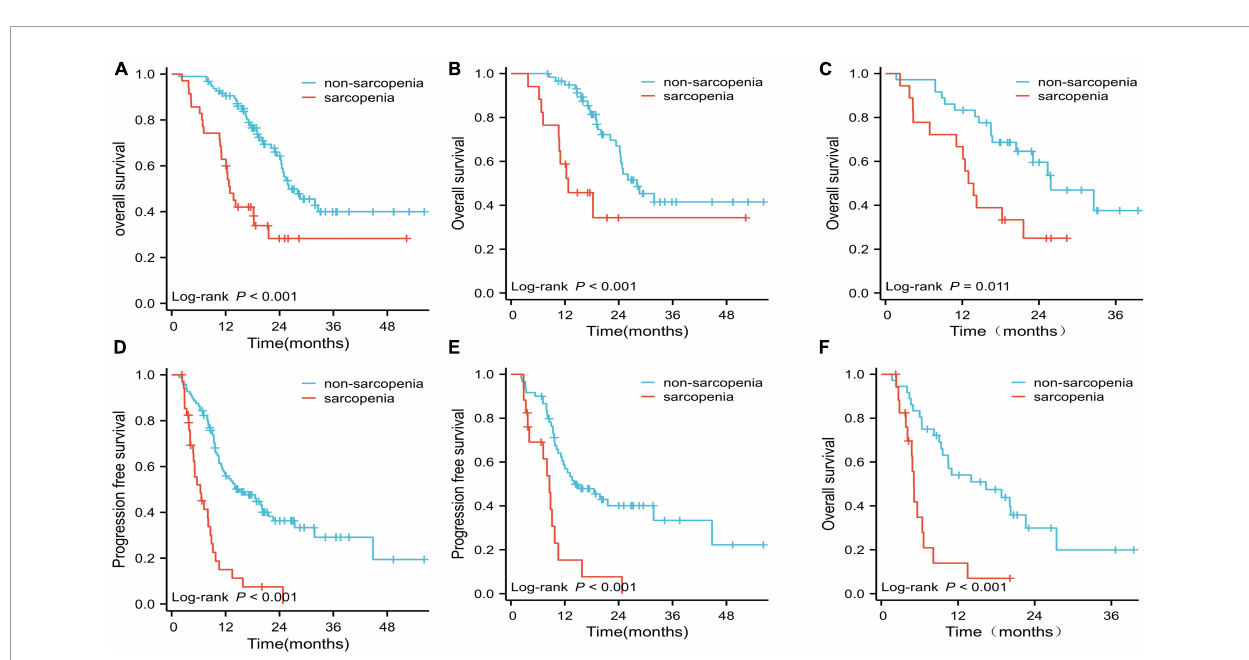
FIGURE2 Overall survival (OS) and progression-free survival (PFS) curves. (A) OS for the two groups in the whole cohort; (B) OS for the two groups treated with EGFR-TKIs; (C) OS for the two groups treated with ICIs; (D) PFS for the sarcopenia and non-sarcopenia groups in the whole cohort; (E) PFS for the two groups treated with EGFR-TKIs; (F) PFS for the two groups treated with ICIs.